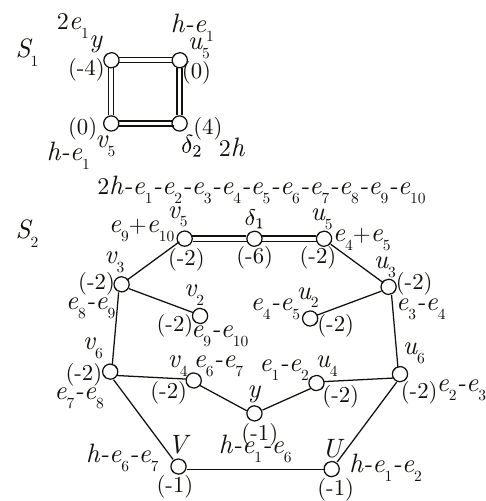
Figure 25 . The con(cid:12)guration of curves on S 1 and S 2 in the geometry (D.88). The number in the bracket denotes the self-intersection number of the curve. The letters U , V , u i , v i , denote an intersection curve with the corresponding